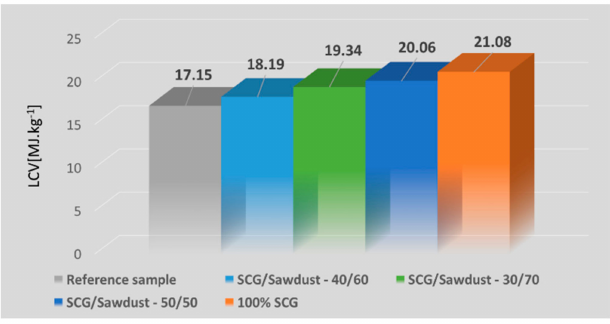
Figure 3. Lower calorific values of tested